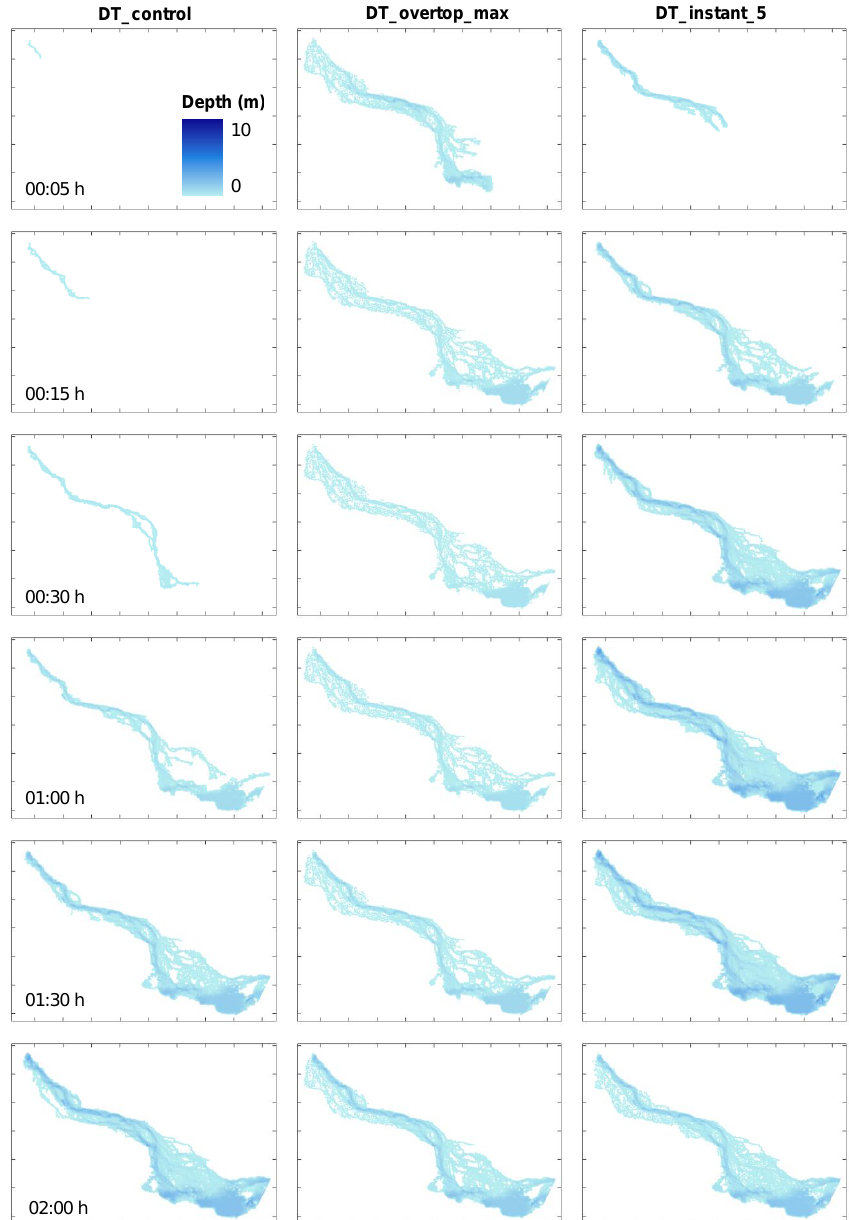
Figure 12. Inundation extent and flow depth distribution for selected time steps for the DT_control, DT_overtop_max, and DT_instant_5 optimal flood even. See Fig. 1a for location. Inset tick marks spaced at 200m